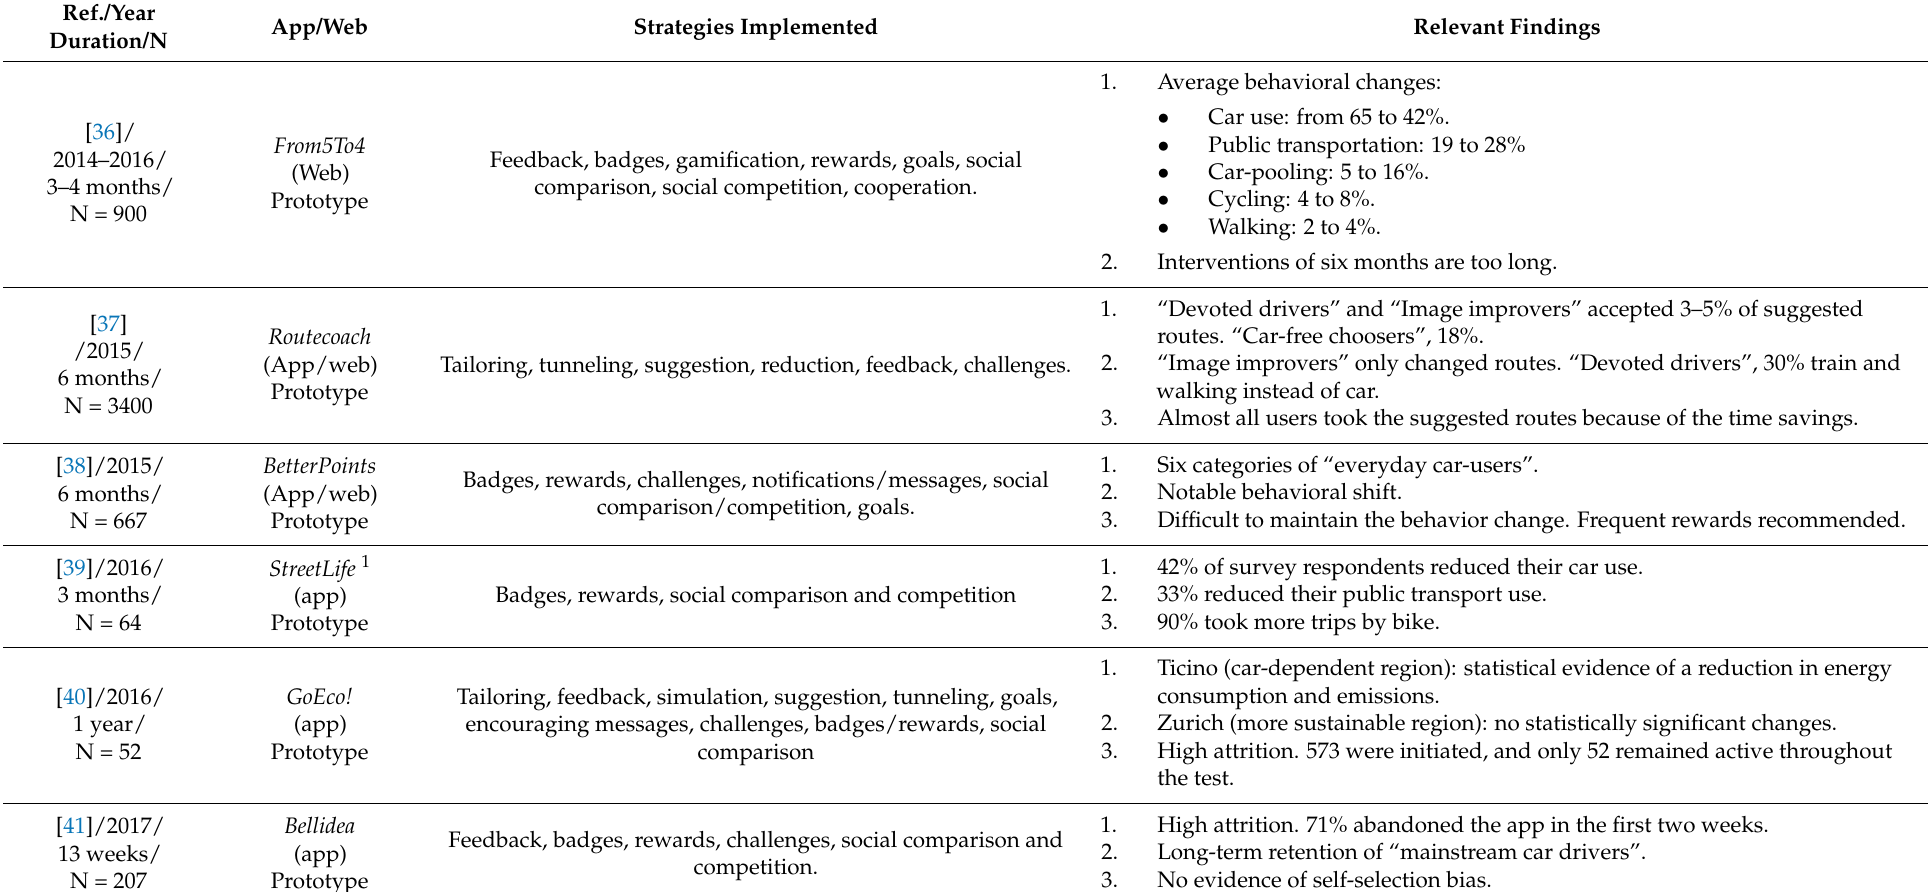
Table 2. Pilot apps and webs tested by a period of more than three